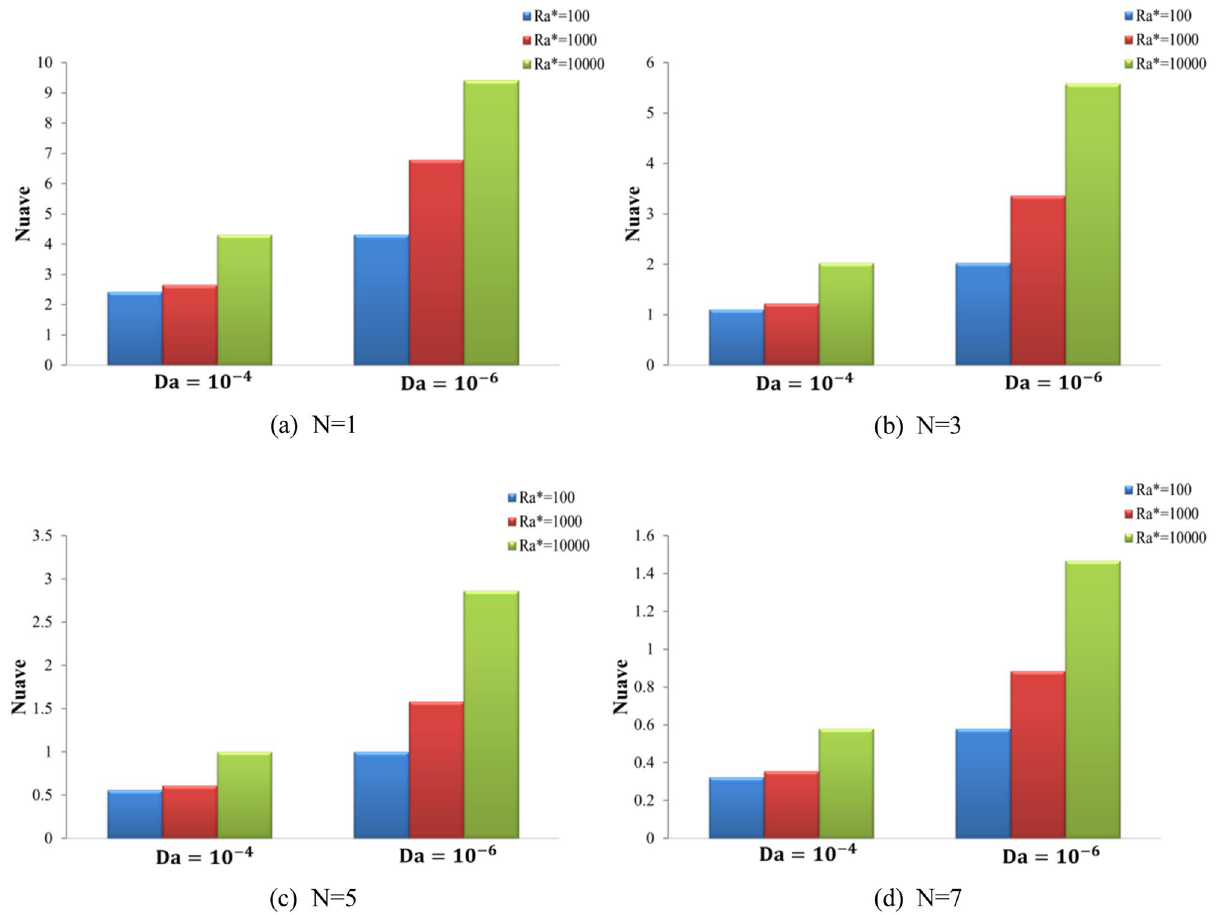
Figure 12. Variation of average Nusselt number (Nu ave ) with hot wavy wall for diverse Ra* and Da at A = 0.1, ϕ = 0.01, and ( a ) N = 1, ( b ) N = 3, ( c ) N = 5, and ( d ) N = 7.